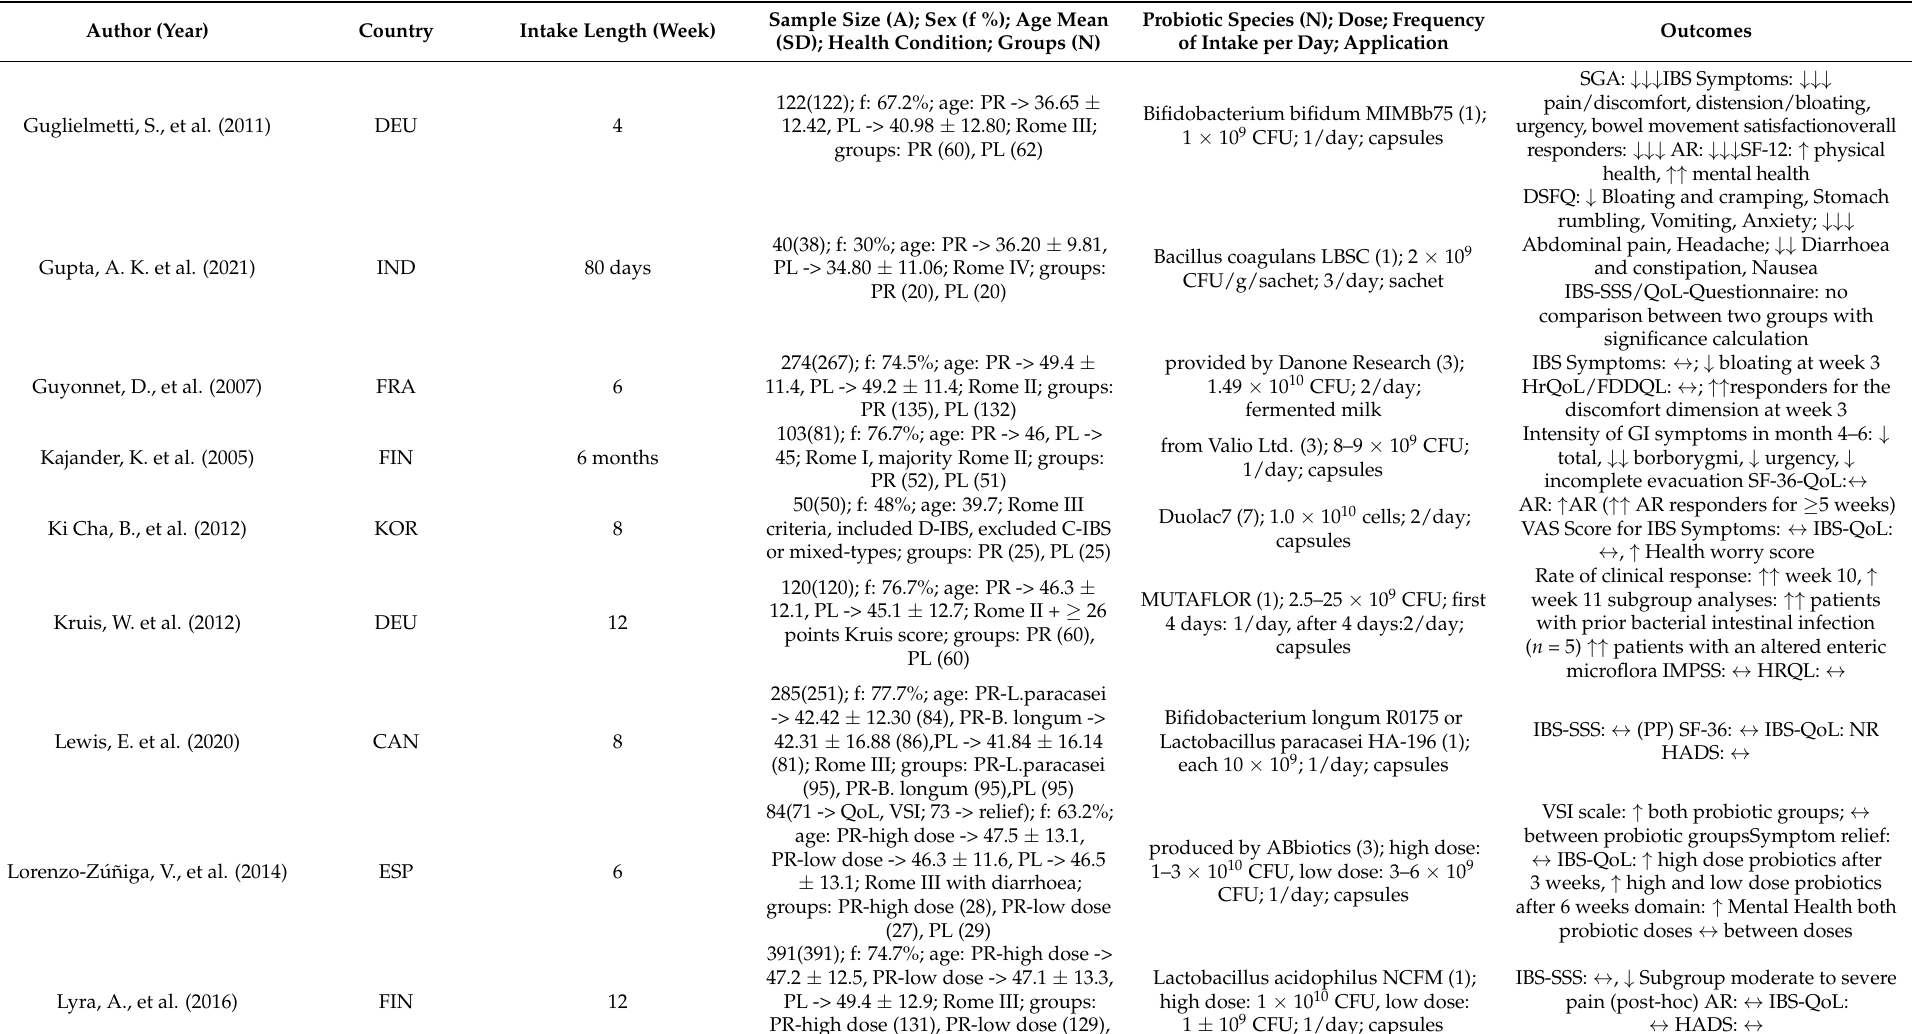
SGA: ↓↓↓ IBS Symptoms: ↓↓↓ pain/discomfort, distension/bloating, urgency, bowel movement satisfactionoverall responders: ↓↓↓ AR: ↓↓↓ SF-12: ↑